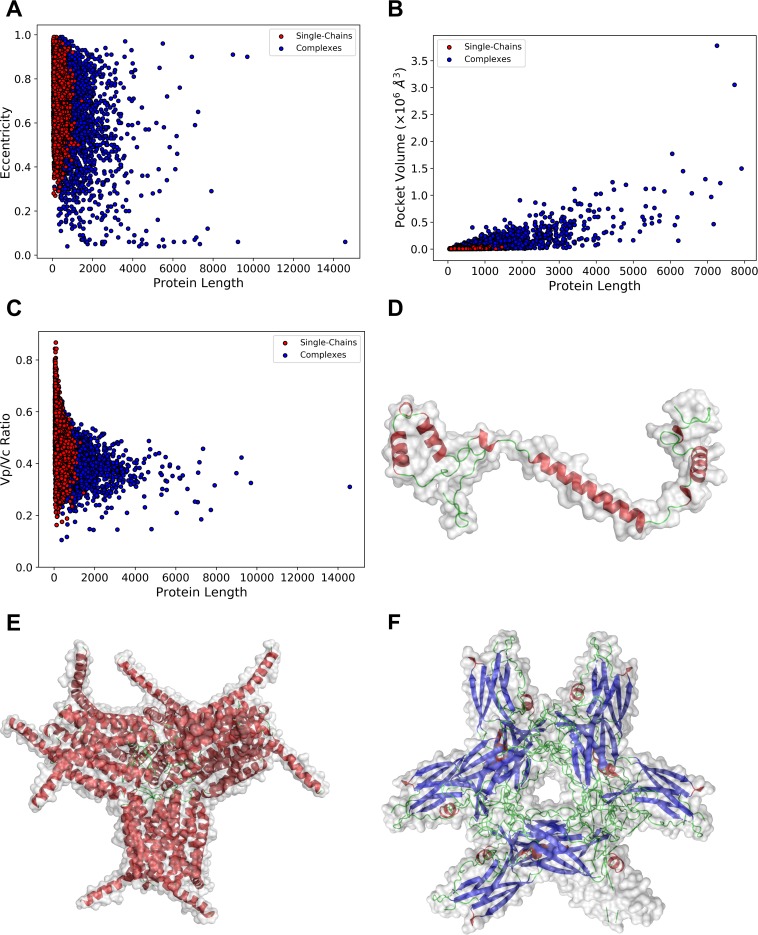
The eccentricity, the pocket size, and the Vp/Vc ratio relative to the protein length.(A), the eccentricity of proteins was plotted relative to the protein length. Red, single-chain proteins; blue, complex structures. (B), the pocket volume (Å3) relative to the protein length. (C), The Vp/Vc ratio relative to the protein length. (D), an example of single-chain proteins that have a small Vp/Vc ratio. 3ag3I, a 72 residue-long protein, which has a Vp/Vc ratio of 0.29. (E), An example of complex structures with a small Vp/Vc ratio. 3pcv, a complex with 12 chains with a total of 1,752 residues. The Vp/Vc ratio is 0.147. (F), another example of complex structures with a small Vp/Vc ratio. 3p69, a complex with 12 chains with a total of 1,524 residue long. The Vp/Vc ratio is 0.295.